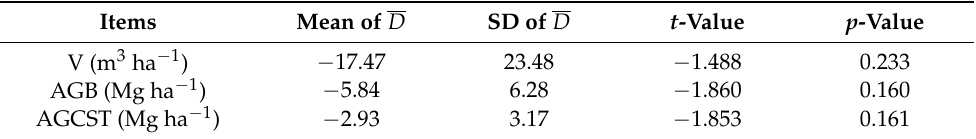
Table 7. The stand volume (V), aboveground biomass accumulation (AGB), and aboveground carbon storage (AGCST) predicted by the DDM (diameter distribution model) and AM (allometric model) and using the paired sample t -test to compare each item by two models for the Konishii fir plantation, where D is the distance between each item predicted by DDM and AM (using